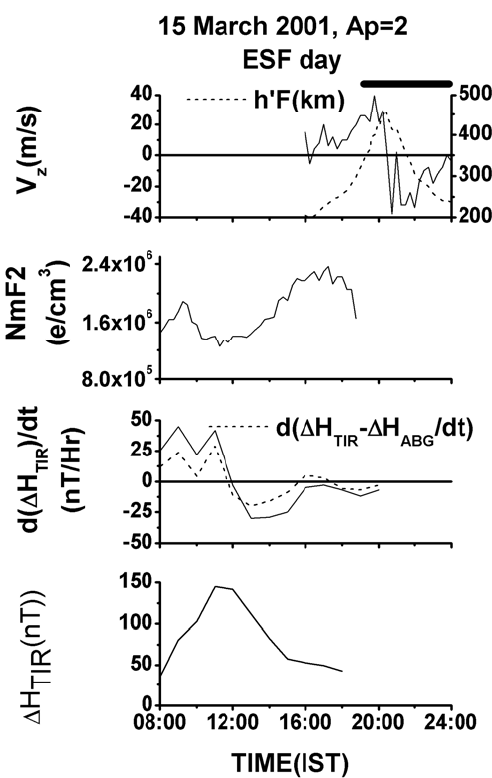
Fig. 1b. Same as in Fig. 1a but on a non-ESF day of 4 March